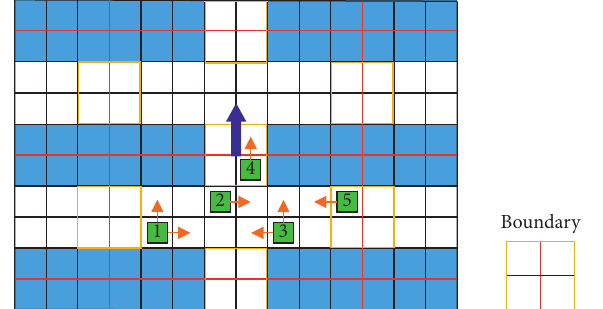
Figure 5: Illustration of the candidate actions. Green squares represent the robots in the district. The blue arrow indicates the next district where these robots are heading to. Therefore, the orange arrows for each robot represent the candidate actions they can take. Besides the actions represented by these orange arrows, staying still is also included in the candidate actions for each time